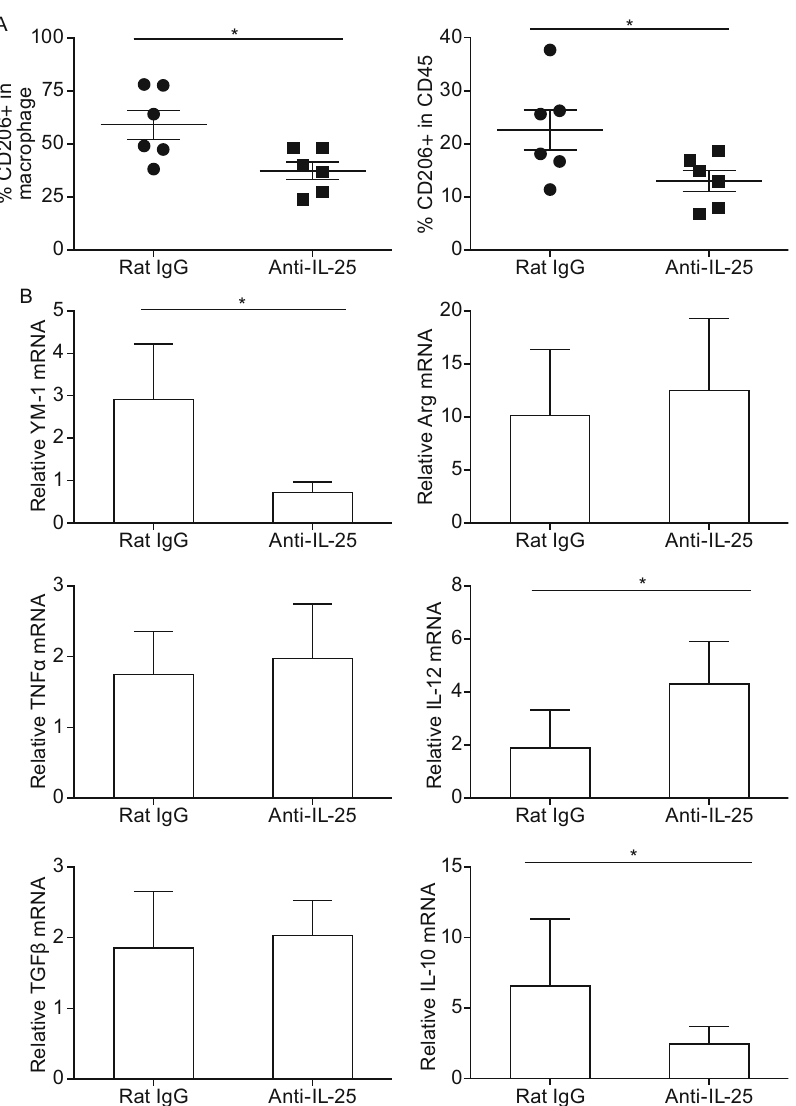
Figure 5. Anti-IL-25 antibody treatment dampened the polarization of M2 macrophages in primary tumor. The MMTV-PyMT mice were treated with either Rat IgG or anti-IL-25 antibody starting from 4 weeks old to 14 weeks old (3 – 7 mice/group), and then sacri fi ced at 14 weeks old for the following analysis. (A) Staining of CD206 positive macrophage populations in mammary carcinomas (shown as mean ± SE). (B) The relative mRNA level of YM-1 and Arg in sorted tumor macrophages or the relative mRNA level of Il10, Il12, Tgfb and Tnfa genes in the total